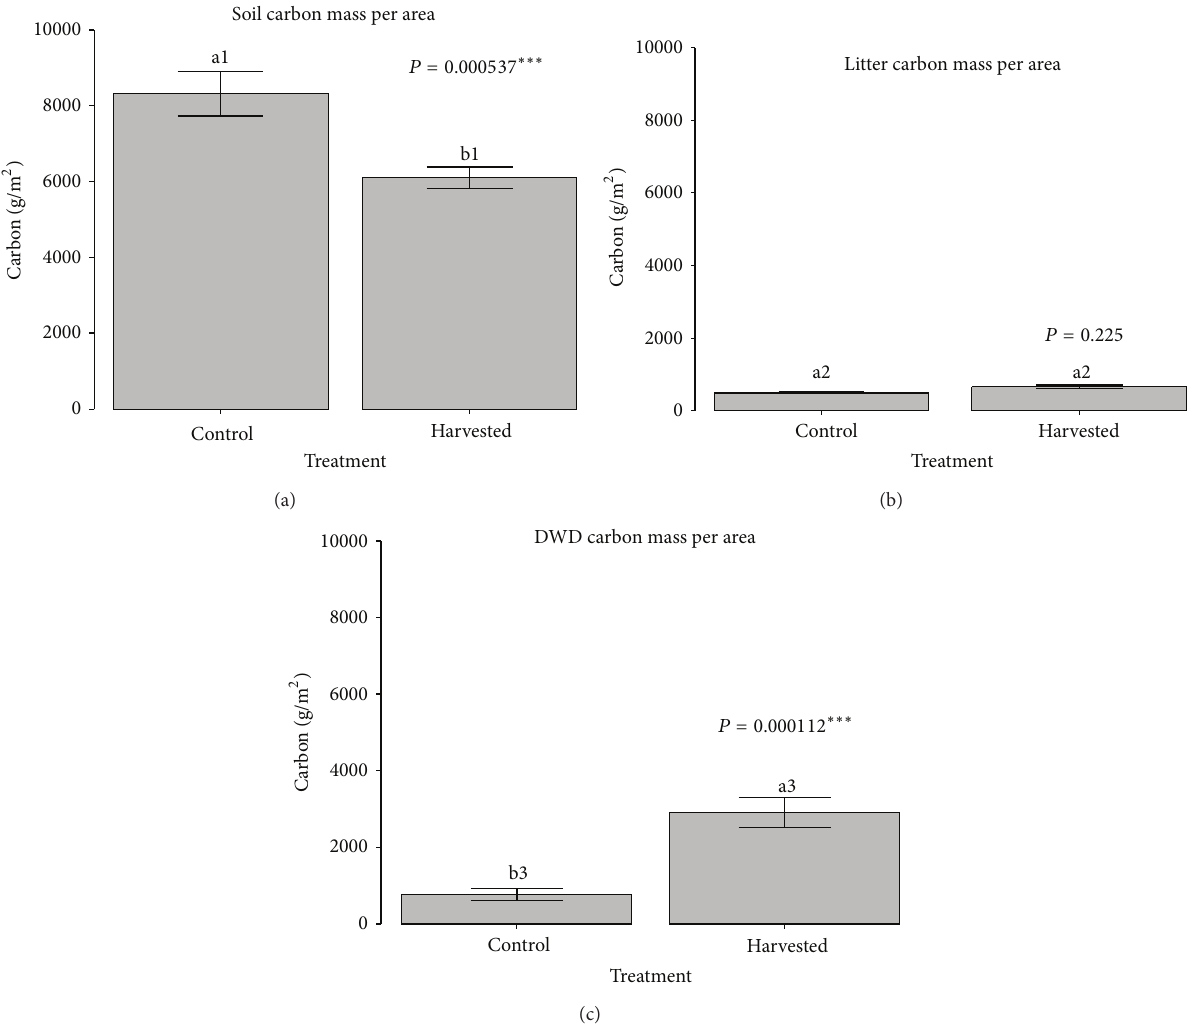
Figure 3: Mass per area of each carbon pool by treatment. Tukey paired t -tests between the variables indicate level of significance at 0.05 level whereby a > b. Different letters indicate significant